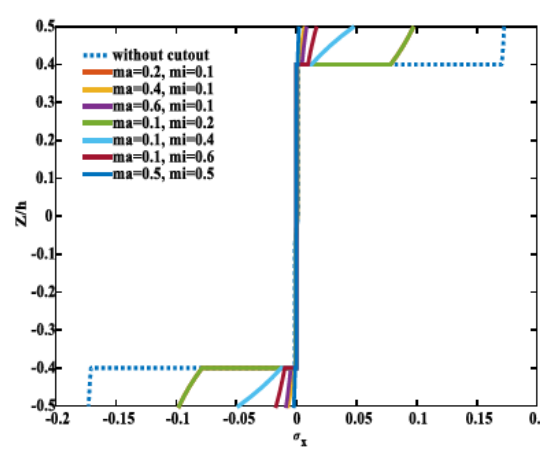
Figure 12: Variation of σ x for LCSP having different cutouts formly distributed load of q0 = 100. It is clear from the table that, with an increase of face thickness ( h f ), the deflection decreases. It is because of the increase in the thickness of stiffer material (face or skin). With the increase of major and minor axis radii of the elliptical hole, deflection in- creases due to decrease in resisting area to the load. Plate without cutout shows minimum deflection and weakened with cutout. It is interesting that with just doubling the face sheet thickness the deflection gets reduced by